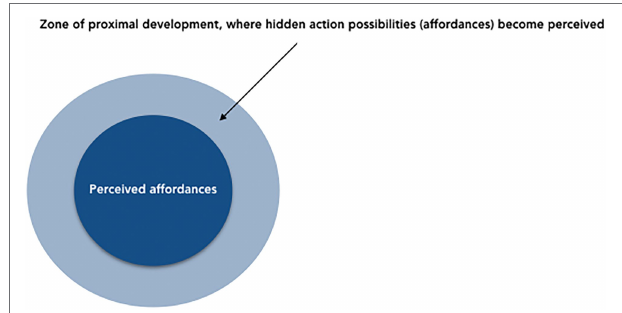
FIGURE 5 | The zone of proximal development as an extension of children’s action